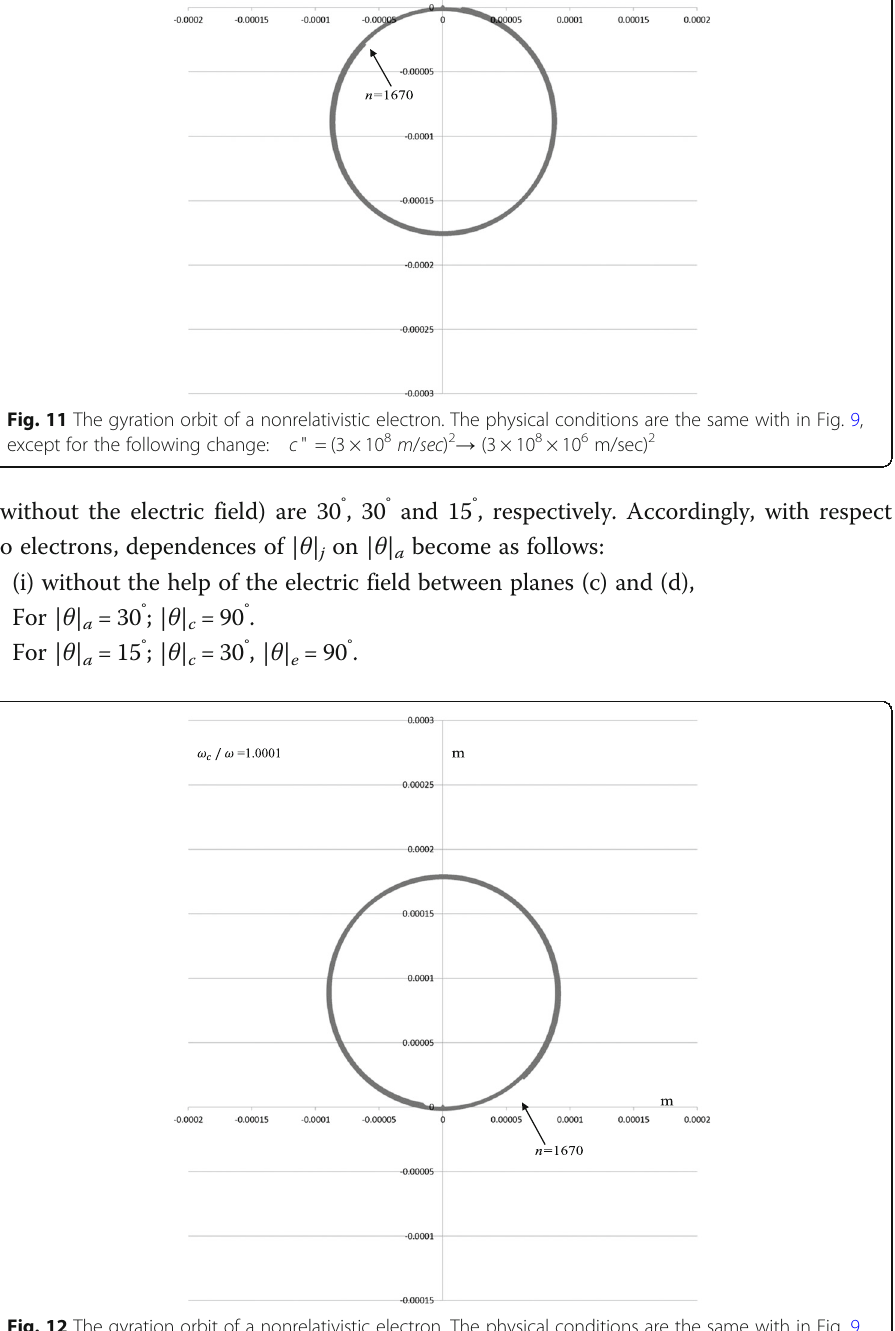
^ z z ¼ − ^ z 0 : 31 (cid:2) 10 8 → þ ^ z 0 : 31 (cid:2) 10 8 m = s 0 c } ¼ ð 3 (cid:2) 10 8 m = sec Þ 2 → ð 3 (cid:2) 10 8 (cid:2) 10 6 m = sec Þ